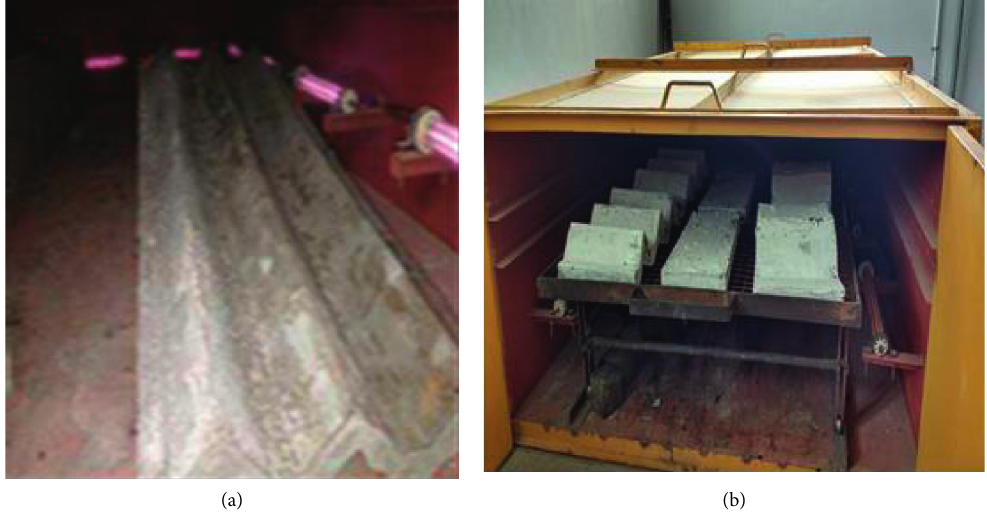
Figure 5: Curing specimens. (a) Specimens under curing. (b) Temperature-controlled heat curing